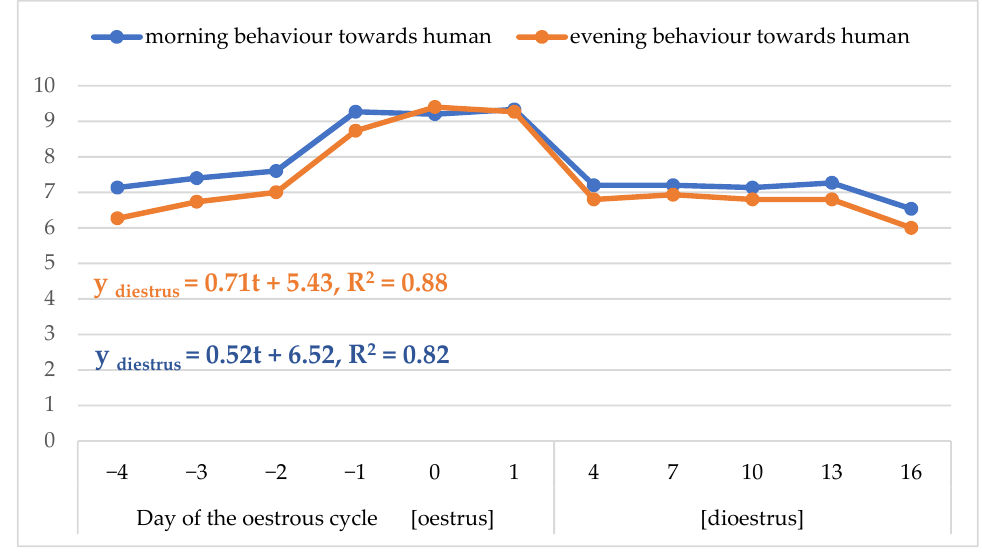
Figure 4. Dynamics of changes in mean scores for the behaviour towards human in the morning and evening during the oestrous cycle and regression models for